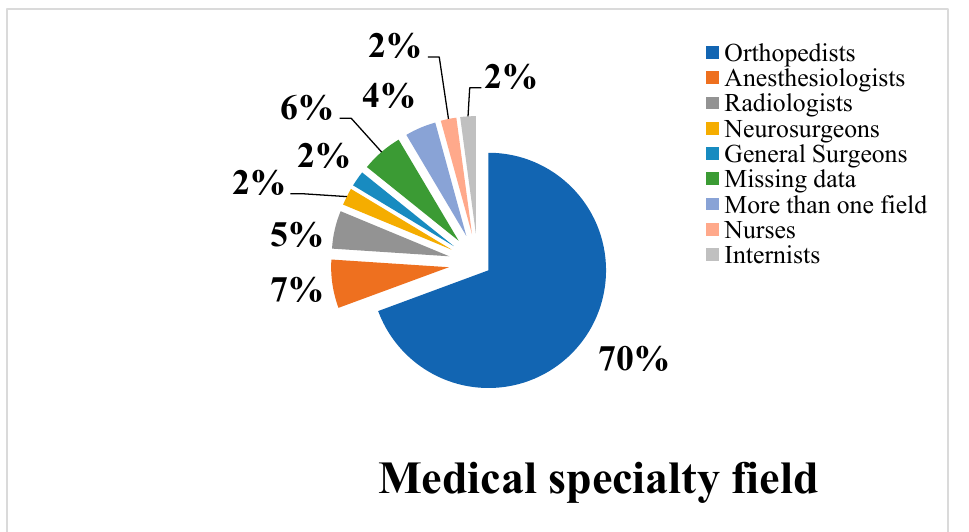
Figure 4. Graph showing the number and specializations of professionals involved in the criminal cases under study (total: